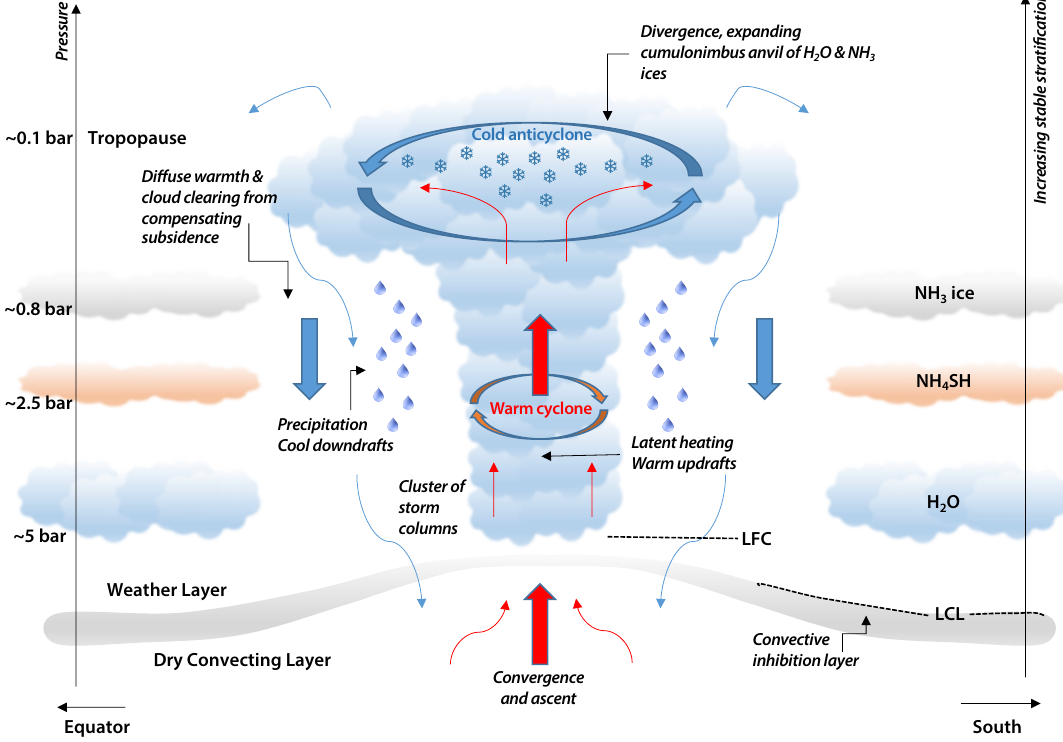
Figure 21. Cartoon showing a moist convective plume in Jupiter’s SEB. The LCL (lifting condensation layer), LFC (level of free convection), and CIN (convective inhibition layer) are indicated, as well as approximate altitudes of the cloud decks. Adapted from Fletcher et al.